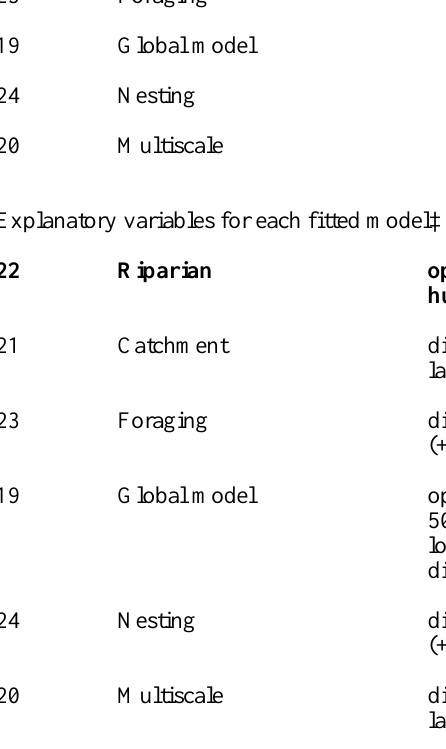
Table 7. Summary of results for New Hampshire statewide habitat models with their associated Akaike weights. N = 322 lakes. Models with empirical support, i.e., D iAIC